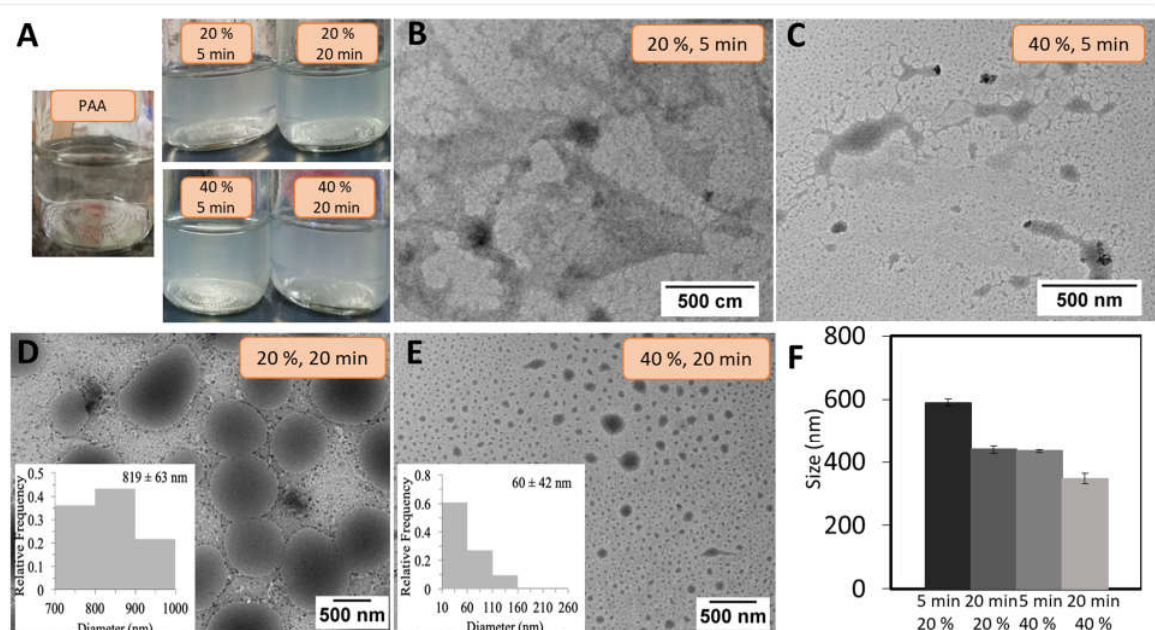
Figure 2. ( A ) pure polyacrylic acid (PAA) (control) and polyacrylic acid/ Schizochytrium sp. (PAA/Schizo) microgels suspensions obtained at various synthesis conditions. Transmission electron microscopy (TEM) micrographs of PAA/Schizo microgels synthesized at 5 min of ultrasound time and ( B ) 20% amplitude, and ( C ) 40% amplitude. 20 min of ultrasound time at ( D ) 20% amplitude (polydispersity index (PDI): 0.293 ± 0.031) and ( E ) 40% amplitude (PDI: 0.35 ± 0.071). ( F ) The hydrodynamic diameters of PAA/Schizo microgels synthesized at the same described conditions obtained by dynamic light scattering. Data shown is the mean of three independent measurements ± standard deviation (SD).